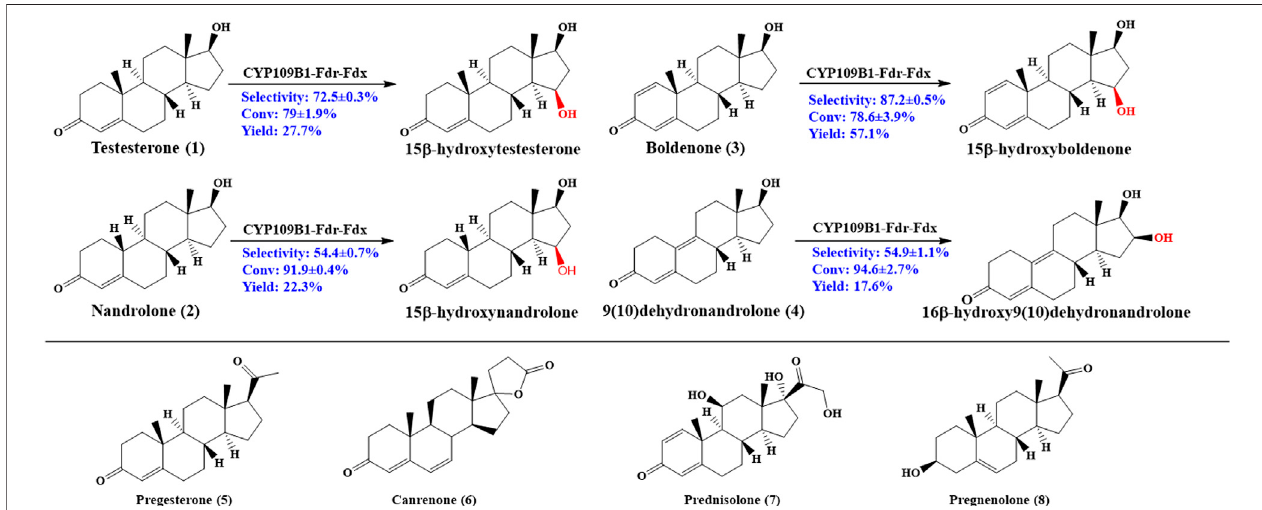
FIGURE 2 | Regio- and stereoselective hydroxylation with CYP109B for eight different steroid substrates: testosterone (1), nandrolone (2), boldenone (3), 9 (10)- dehydronandrolone(4),progesterone(5),Canreone(6),Prednisolone(7)andPregnenolone(8).WholecellreactionofCYP109B1-Fdr_Fdxdisplayedcatalyzeactivity for substrate 1 to 4 , and major products were